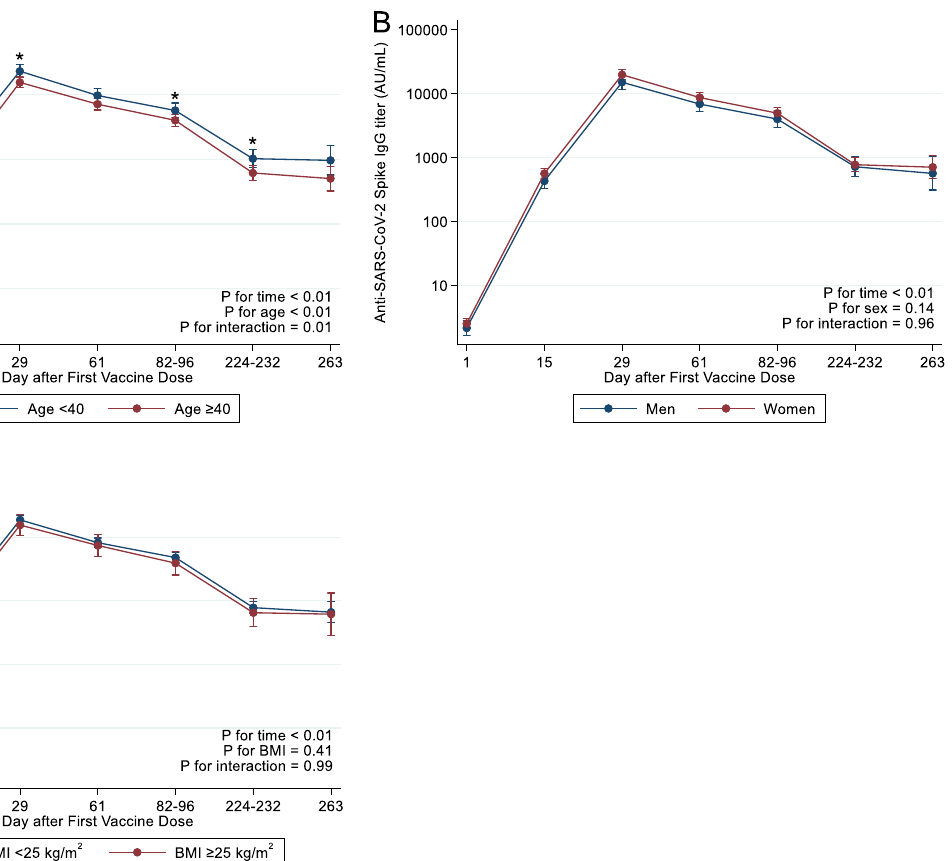
Figure 2. SARS-CoV-2 spike specific IgG titers by background factors. Wald test was used to compare the mean differences of IgG-S-RBD titers between background factors at each time point using STATA version 17.0. ( A ) SARS-CoV-2 spike specific IgG titers by age (< 40 or ≥ 40 years), ( B ) SARS-CoV-2 spike specific IgG titers by sex (men or women), ( C ) SARS-CoV-2 spike specific IgG titers by BMI (< 25 or ≥ 25 kg/m 2 ). SARS-CoV-2 spike specific IgG titers were measured on the following schedule: day 1 (immediately after the first dose) (n = 100), day 15 (n = 100), day 29 (7 days after the second dose) (n = 97), day 61 (n = 97), day 82–96 (n = 96), day 224–232 (n = 66), and day 263 (n = 19).